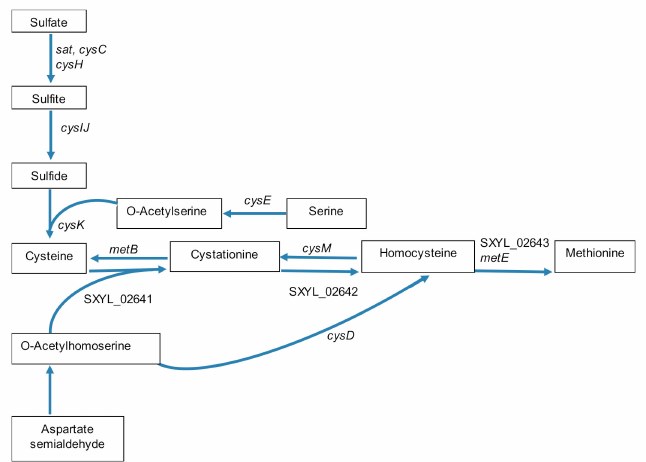
Figure 3. Scheme of synthesis pathways of cysteine and methionine by Staphylococcus xylosus in solid dairy matrix showing the overexpressed genes (the level of expression of these genes and the name of the corresponding enzymes are given Table